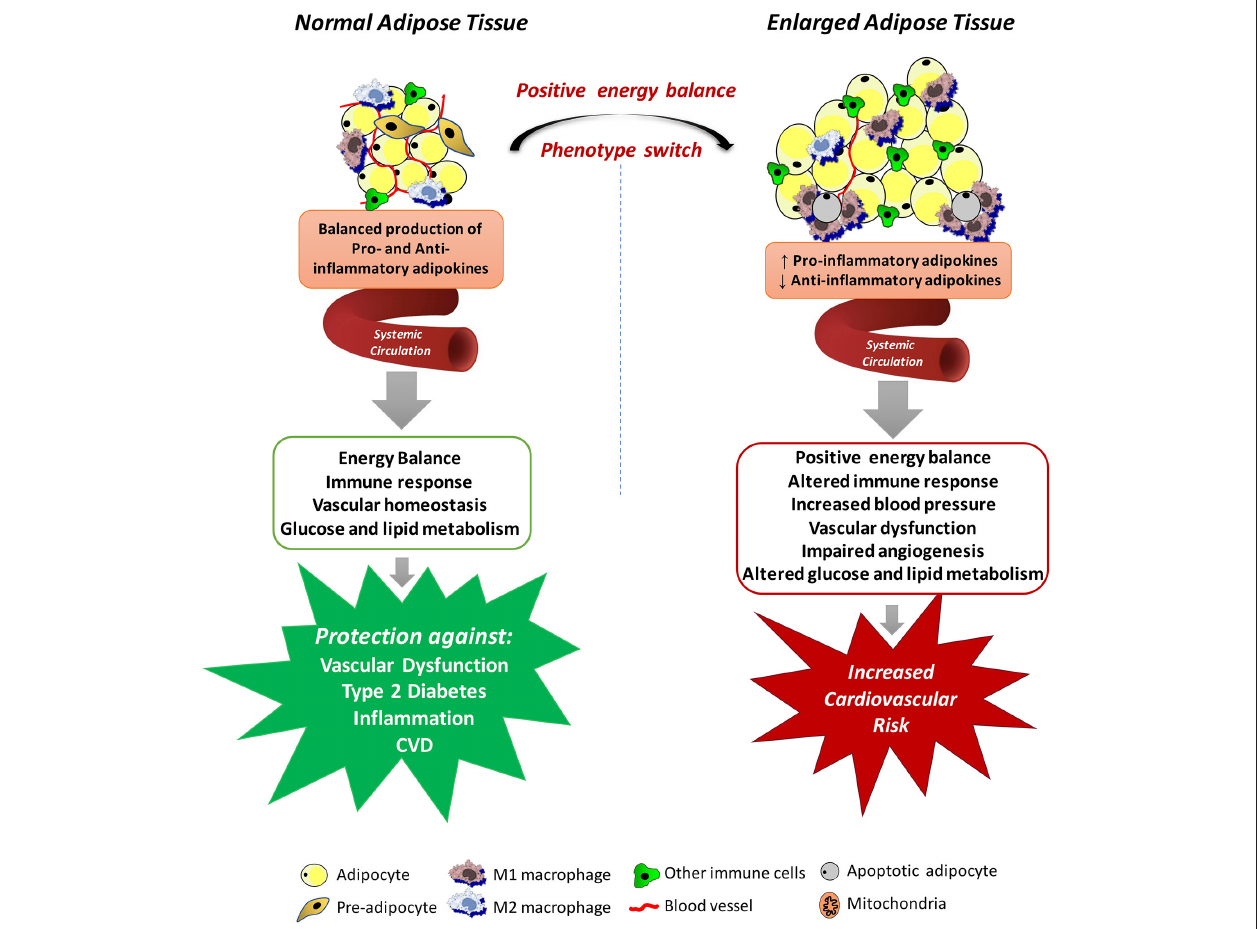
FIGURE 1 | Mechanisms by which systemic adipose tissue dysfunction could lead to the development of vascular dysfunction in obesity. Adipose tissue produces various chemokines, cytokines and hormones, which are secreted into the circulatory system and act in several physiological processes, including energy balance, immune responses, blood pressure, vascular homeostasis and angiogenesis, glucose and lipid metabolism. Expansion of the adipose tissue leads to necrotic and/or apoptotic cell death and this is paralleled by infiltration of activated macrophages, increased production of pro-inflammatory adipokines and reactive oxygen species, promoting a state of systemic endothelial cell activation and vascular dysfunction, all of which may contribute to the elevated cardiovascular risk associated with